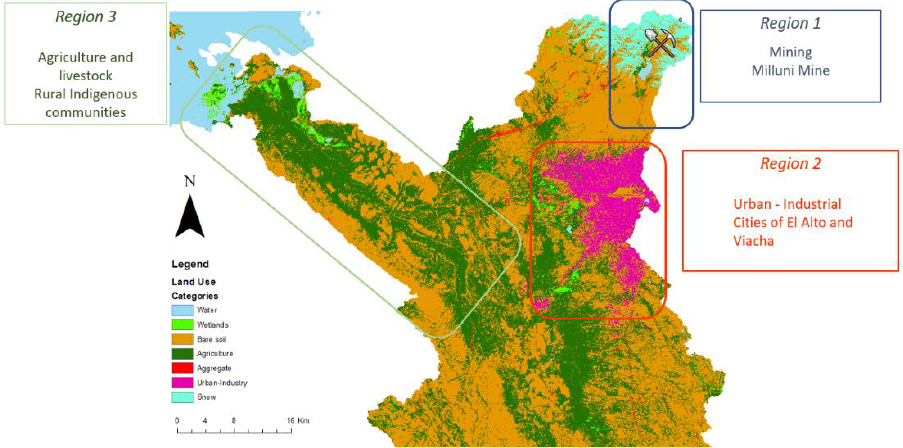
Figure 2. Katari River Basin — Regions of environmental influence.